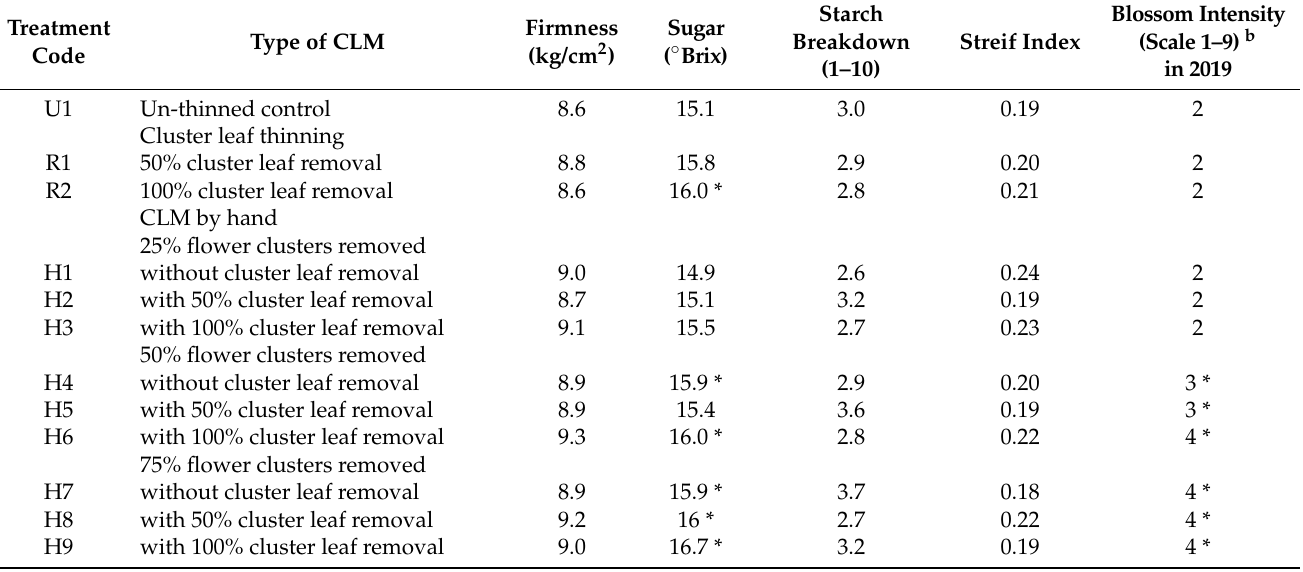
Table 3. Effect of thinning treatment on the maturity of harvest of apple cv. ‘Roter Boskoop’ in 2018 and blossom intensity in 2019.